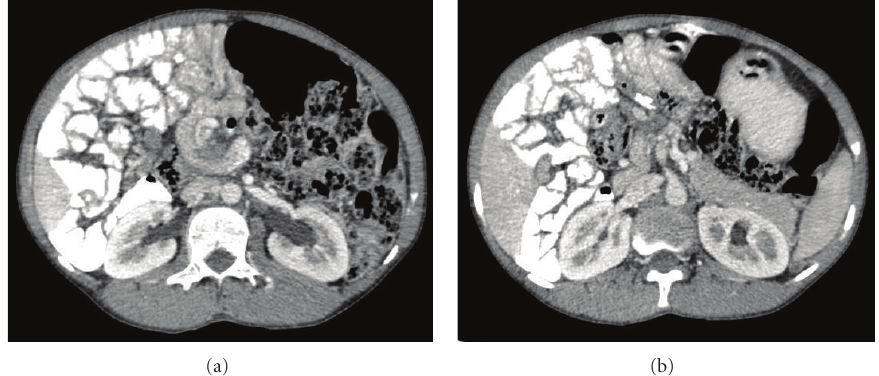
Figure 2: (a) Axial postcontrast CT image showing duodenum and SMV wrapping around axis of SMA in clockwise direction producing the characteristic whirl sign. Dilatation of SMV is also noted. Jejunal loops are seen of on right side of abdominal cavity. (b) Axial postcontrast CT image showing reversal of the normal anatomic relation of the SMA and SMV, that is, SMV is seen on the left side while SMA on the right side.